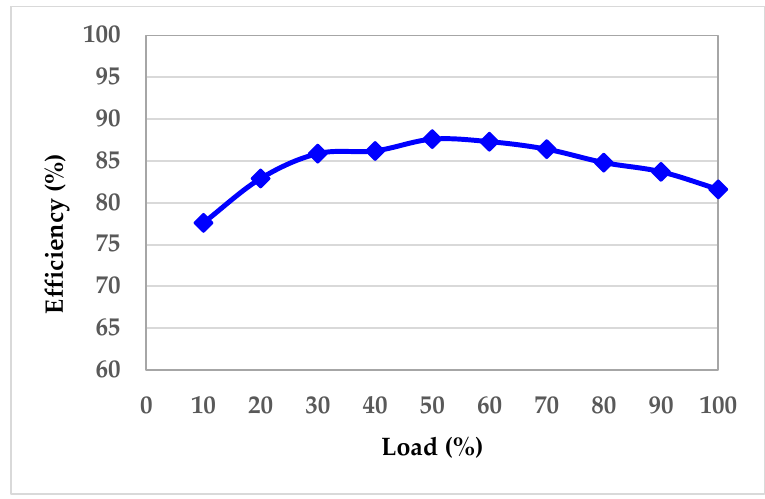
Figure 14. Experimental efficiency measurement of the proposed MIC circuit.